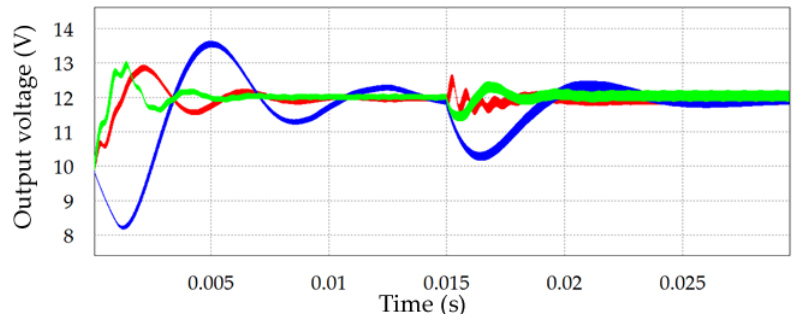
Figure 5. Simulation of flyback switched model using PSIM software. Normalized output voltage x 2 for load perturbation with a fixed time step 100 times smaller than the switching period. SFL (red), PBC (green) and IDAPBC